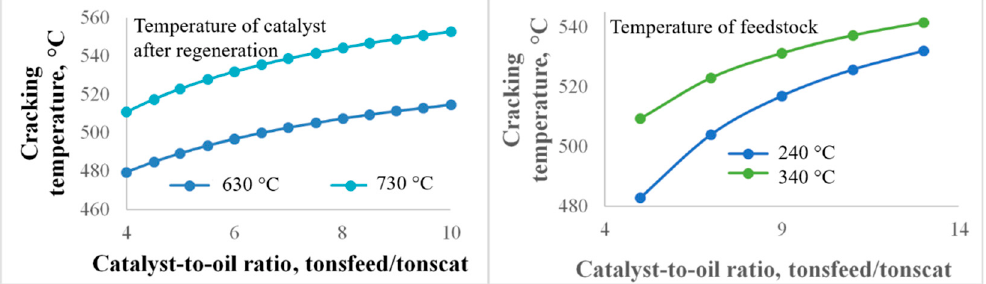
Figure 4. T he sensitivity of the model to SAR content in feedstock.